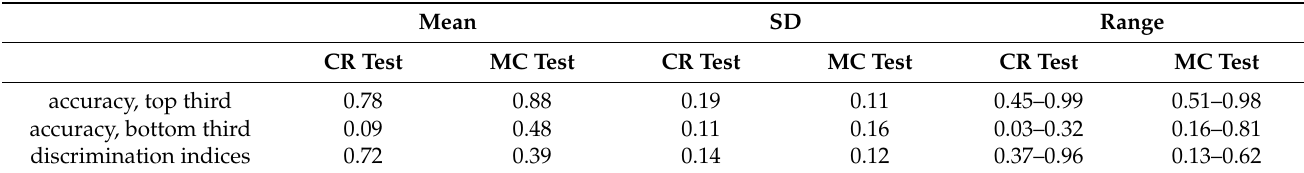
Table 6. CR and MC scores of top and bottom participant terciles and item discrimination indices.